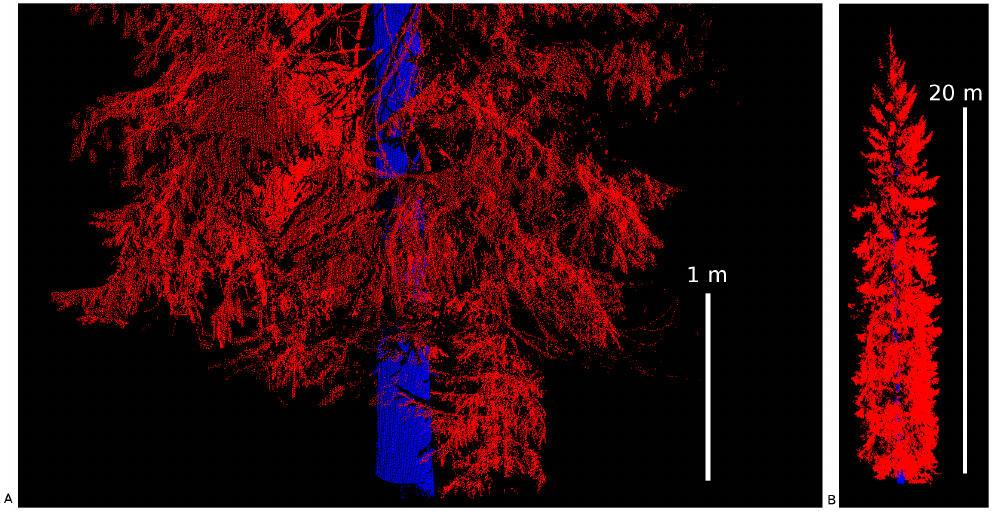
Figure 5. Laser data points of a spruce classified into stem (BLUE) and canopy